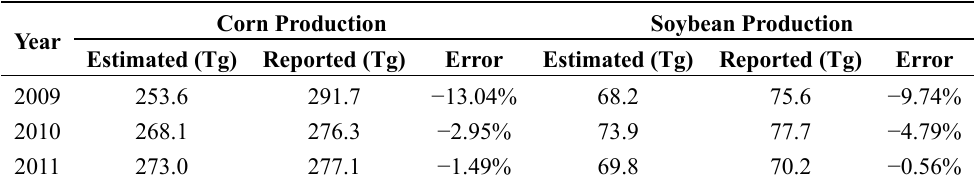
Table 4. Estimated and reported corn and soybean production for 12 states in the Midwestern